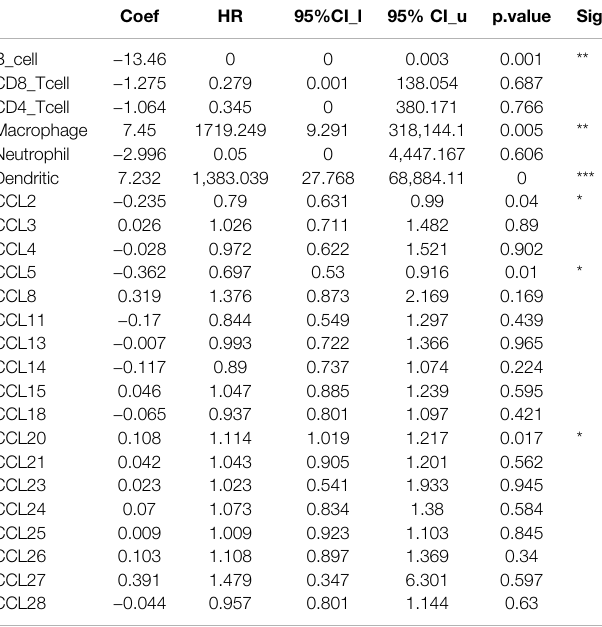
TABLE 4| The cox proportional hazard model ofchemokines CCL and sixtumor- in fi ltrating immune cells in LIHC (TIMER). Coef HR 95%CI_l 95% CI_u